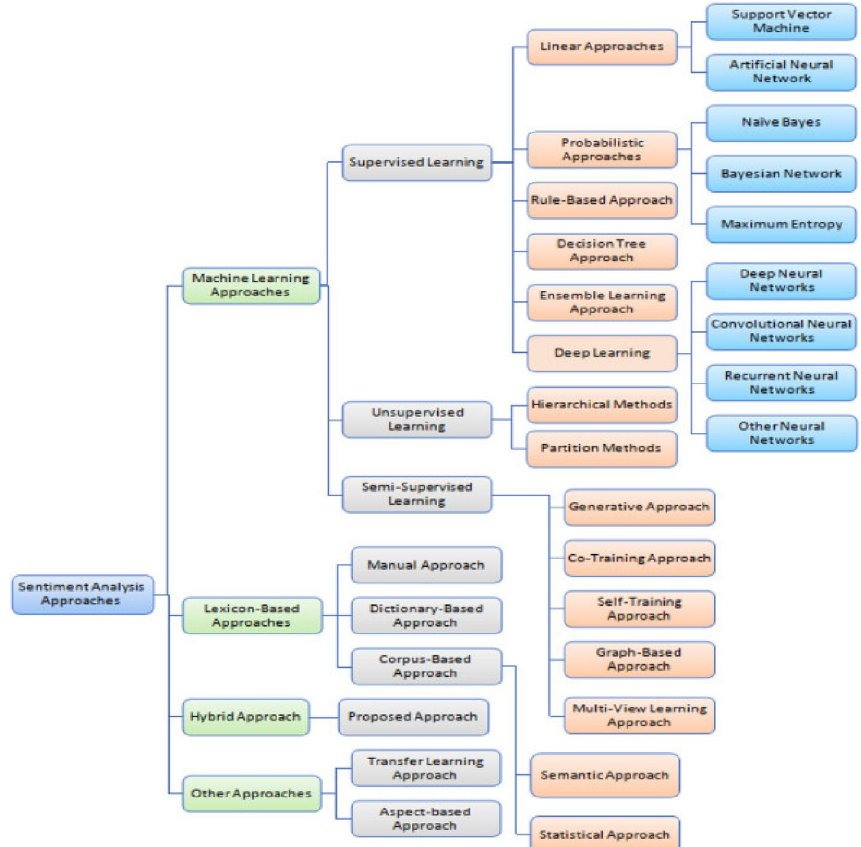
Fig. 1 Sentiment analysis approaches